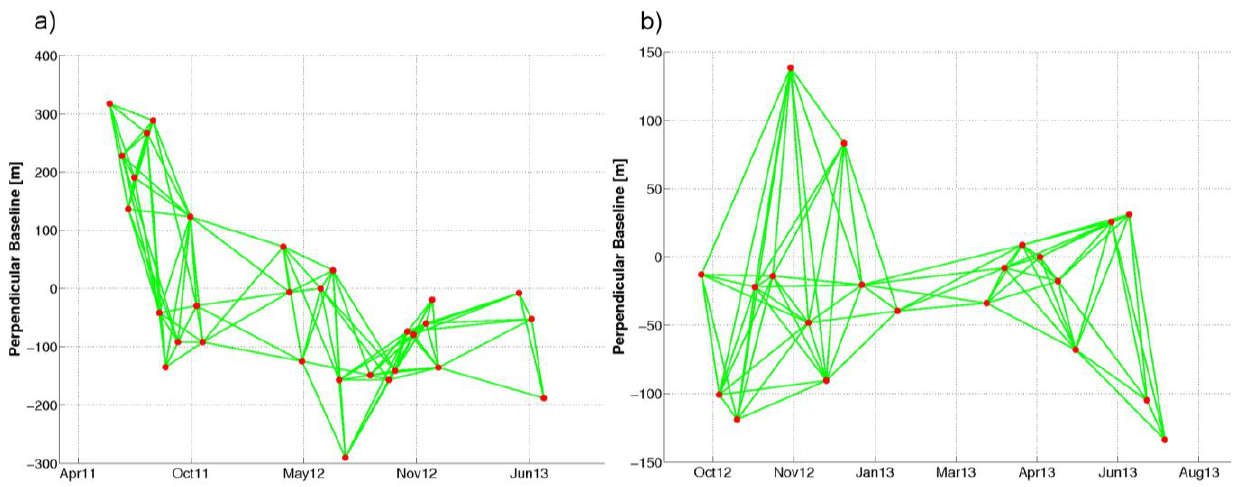
Figure 2. The network of Small BAseline Subset (SBAS) interferograms used for the time series analysis of ascending ( a ) and descending ( b ) TerraSAR-X images. Red dots show the individual Synthetic Aperture Radar (SAR) images and green lines represent the image pairs for interferogram